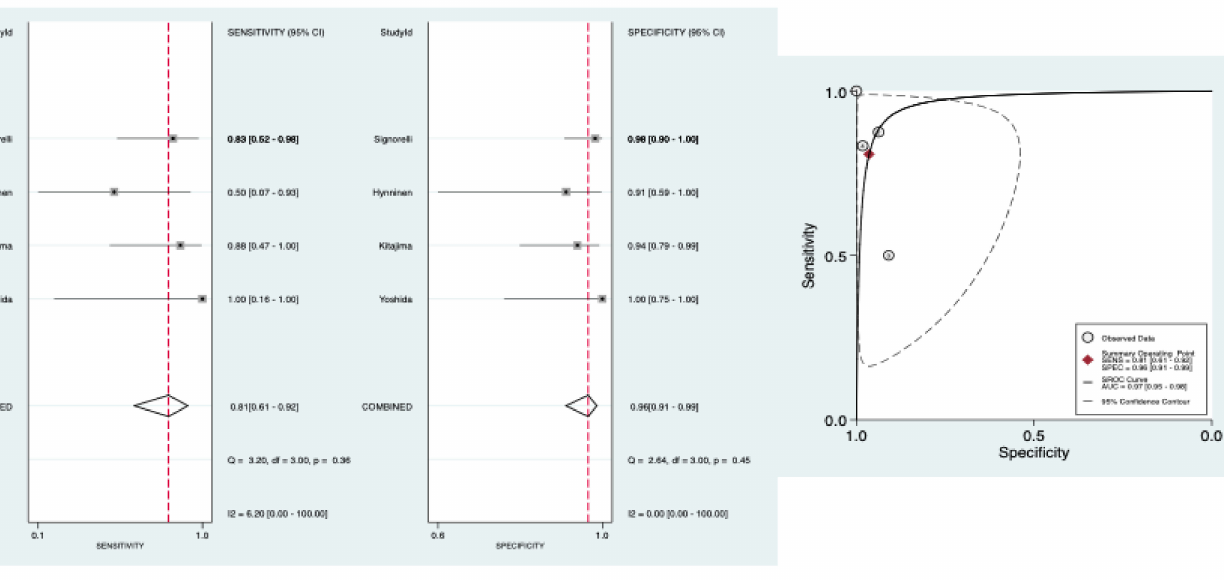
Figure 4. Forest plots of pooled sensitivity and specificity and HSROC of preoperative PET/CT to detect pelvic and para-aortic